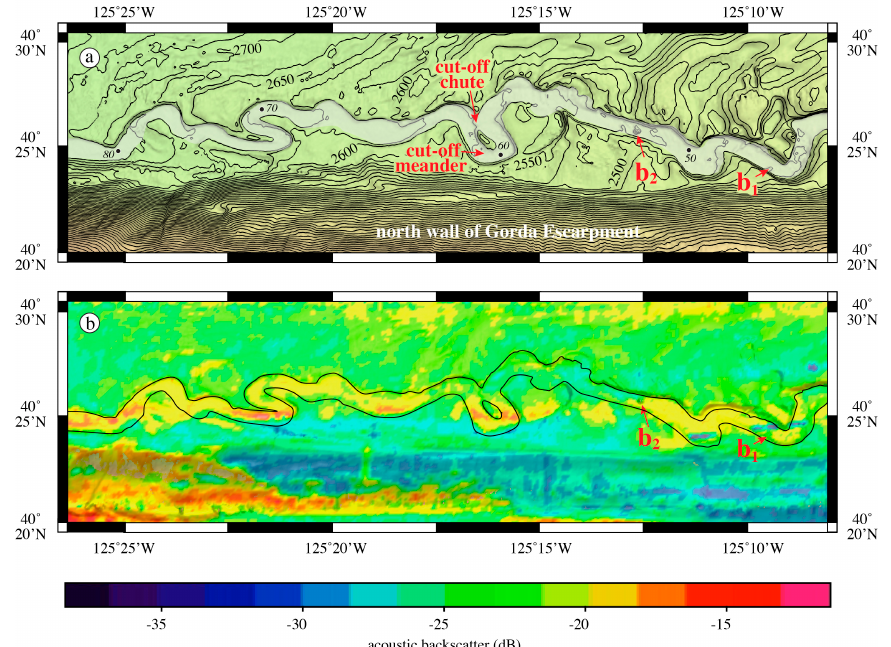
Figure 10. ( a ) Map view of MBES bathymetry and ( b ) backscatter of upper sinuous reach floor (grayed area) and immediate surrounding area. “b 1 ”and “b 2 ” are two large mounds on the floor of the reach. A cut-off meander occurs 14 km down-channel. Black circles in ( a ) mark 10 km distances in italics from the junction of Mendocino and Mattole Canyons. See Figure 2 for location. Isobath interval 25 m; isobaths of north wall of Gorda Escarpment intentionally left